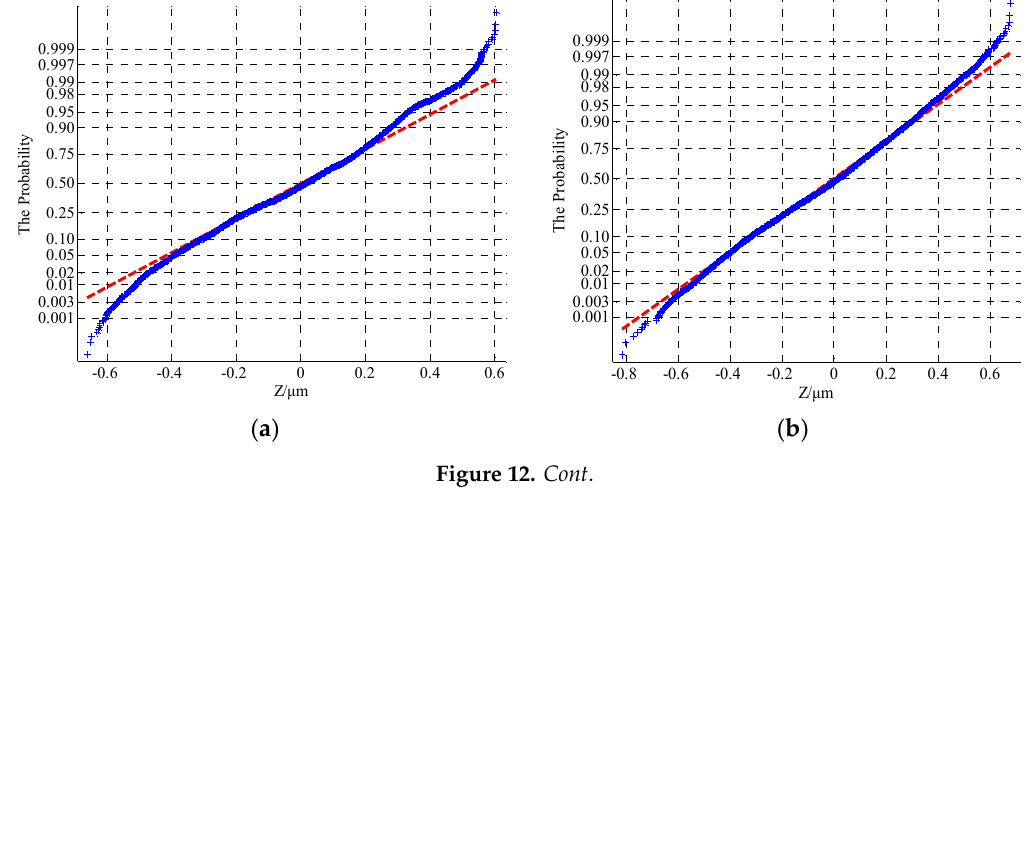
( b ) ( c ) Figure 13. Autocorrelation graphs for different D and G : ( a ) D = 1.5, G = 0.12; ( b ) D = 1.7, G = 0.12; ( c ) D = 1.5, G = 0.52. From Figures 11 and 12, the surface profile data obtained by the fractal theory are basically in accordance with the normal distribution, which is basically consistent with the data distribution law obtained from the actual machining surface. In addition, it can be seen from Figure 13 that the correlation of profile peaks shows a curve with a slight fluctuation after an attenuation with the interval τ , which is also approximately consistent with the correlation law of the measured surface